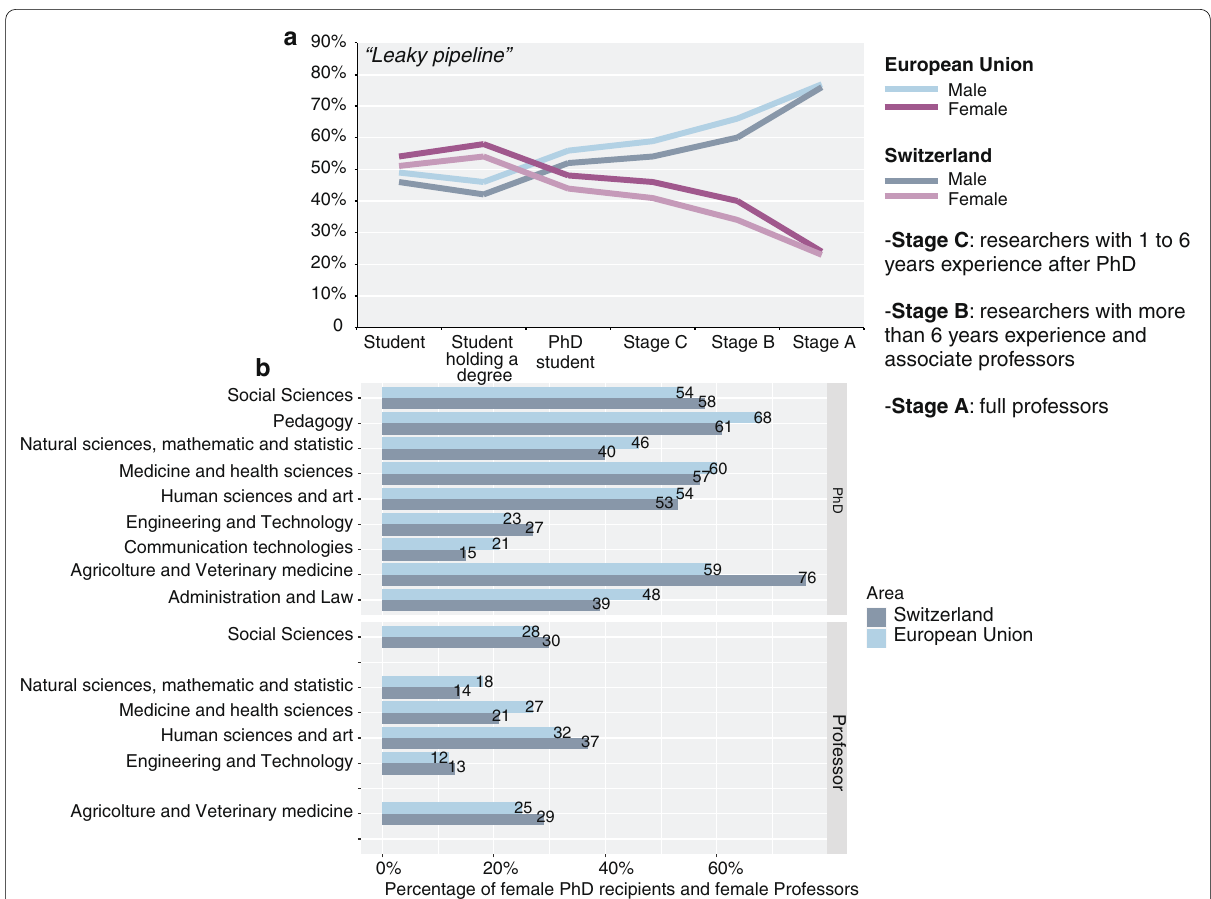
Fig. 1 a The Leaky pipeline , scissor‑shaped curve representing the percentage of women and men in academic careers in Switzerland and the European Union in 2016. b Percentage of female PhD recipients and female professors in Switzerland and in the European Union in 2016, grouped by field. Data from the Swiss Federal Statistical Office (FSO) and the European Commission—She figures